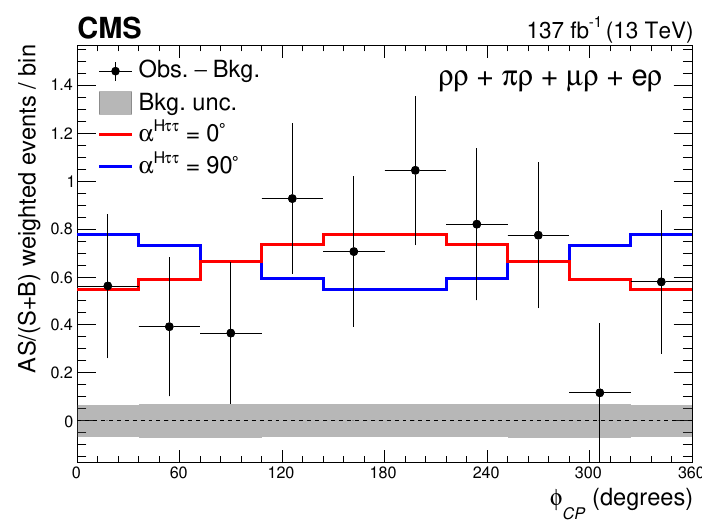
distributions for the rr , pr , mr , and e r channels weighed by A S/ ( S + B ) Figure 14 . The φ CP are combined. Events are included from all MVA score bins in the four signal categories. The background is subtracted from the data. The scalar distribution is depicted in red, while the pseudoscalar is displayed in blue. In the predictions, the rate parameters are taken from their best fit values. The grey uncertainty band indicates the uncertainty in the subtracted background component. In combining the channels, a phase-shift of 180 ◦ was applied to the channels involving a lepton since this channel has a phase difference of 180 ◦ with respect to the two hadronic channels due to a sign-flip in the spectral function of the light